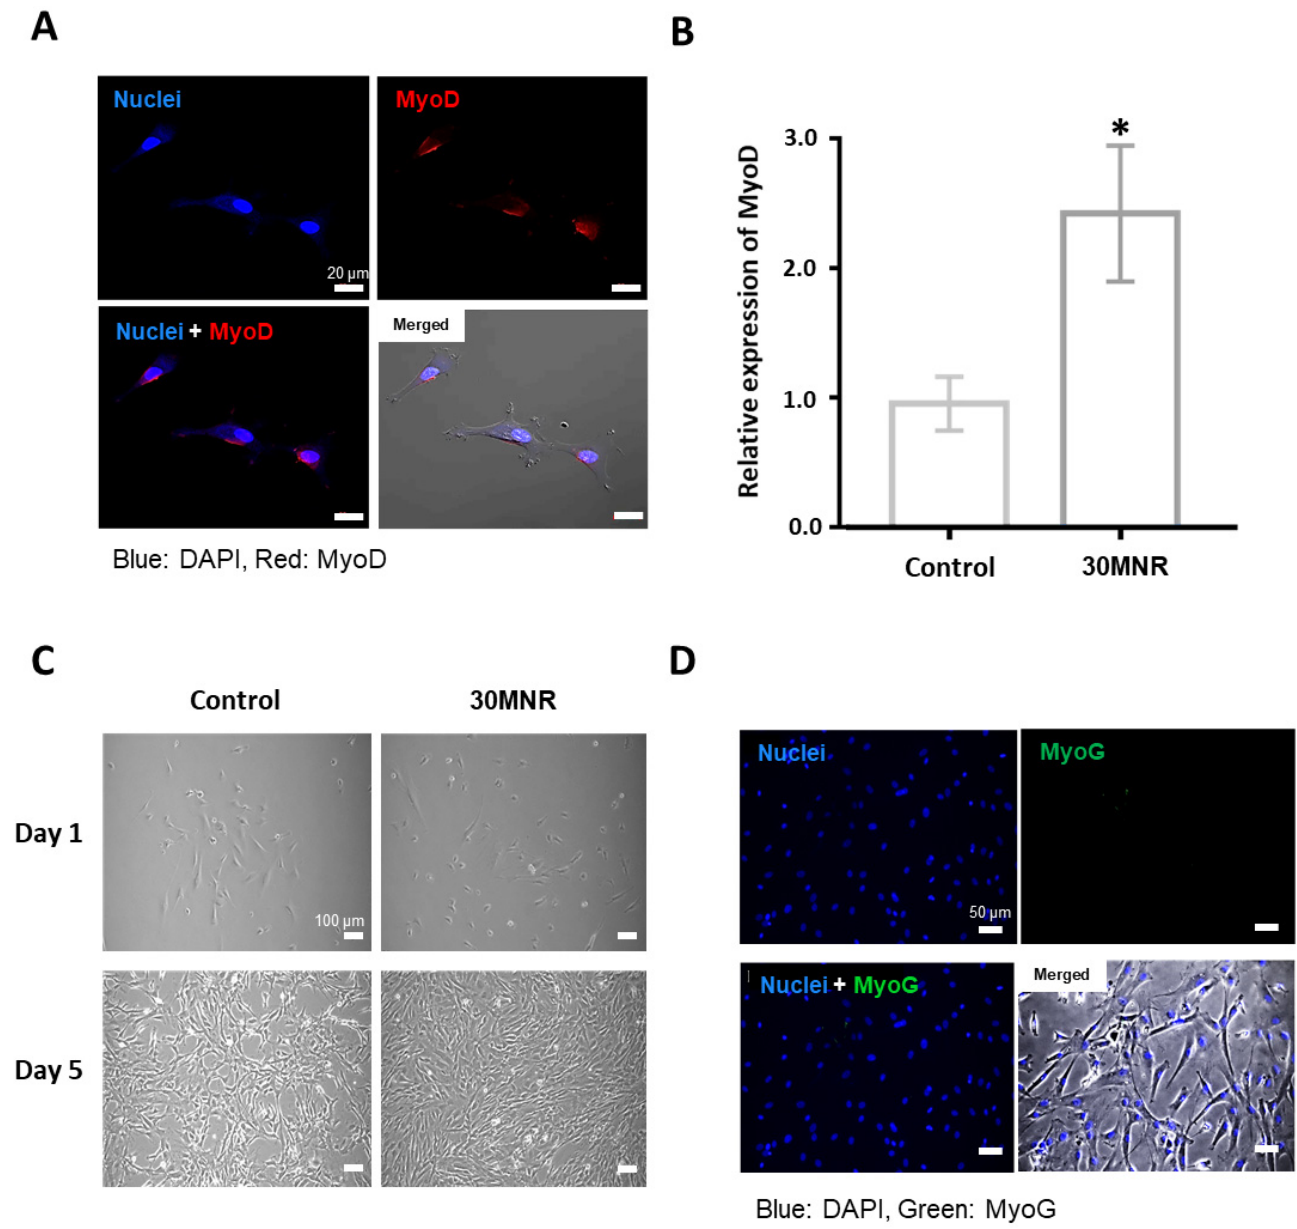
Figure 2. Protein-based direct reprogramming using 30Kc19-bMyoD-NLS-R9 (30MNR) protein. Intracellular delivery of the protein was observed; however, efficiency of reprogramming was not adequate in BDFs cultured with 30MNR protein. ( A ) Immunocytochemistry to confirm intracellular delivery of 30MNR fusion protein in BDFs. Further, 30MNR was indicated by red fluorescence. Scale bars, 20 µm. ( B ) Quantified values of bMyoD fluorescence using Image J. n = 3 per group and statistical significance was determined using one-way ANOVA. * p < 0.05. ( C ) Morphology of cells observed after treatment with 80 µg/mL of 30MLR fusion protein for 5 days. Scale bars, 100 µm. ( D ) Immunocytochemistry to confirm expression of myogenic marker protein, MyoG. Scale bars, 50 µm.